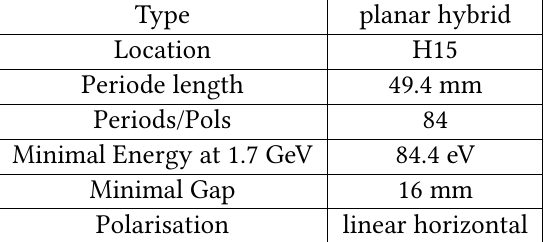
Table 1: Parameters of the undulator